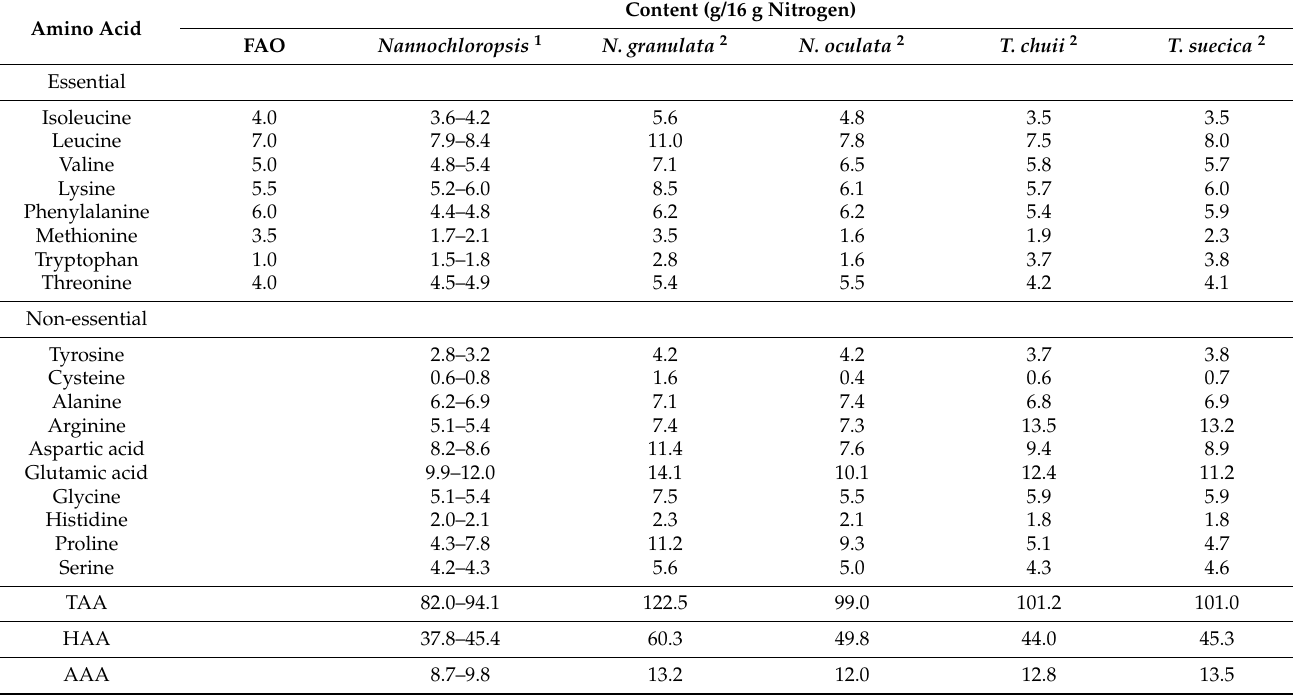
Table 1. Amino acid composition (expressed as g/16 g of nitrogen) of Nannochloropsis sp. and Tetraselmis sp. microalgae and comparison with recommended values by the Food and Agriculture Organization